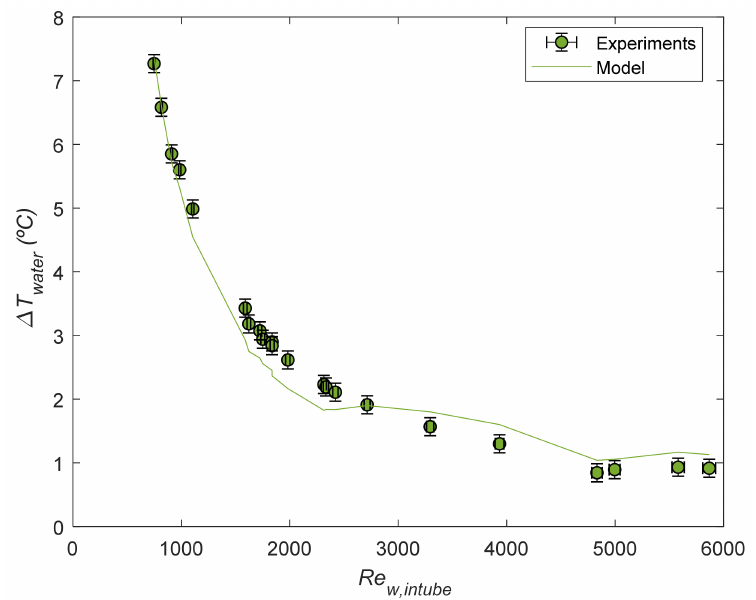
Figure 10. Water temperature difference between inlet and outlet for different Reynolds numbers. Air flow rate and spray flow rate constant. The approach temperature was maintained at the constant temperature of 4 ◦ C.